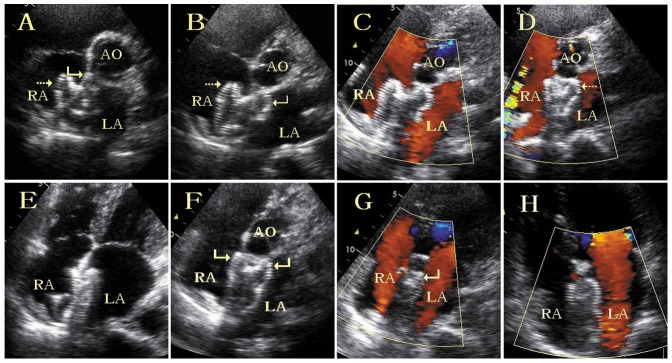
TTE images of the ASO in a patient with ASD with a deficient superior-anterior rim.(A) The left disc upper part was seen to be slipped into the right atrium (curved arrow). (B) After adjusted deployment, the upper parts of the two discs were positioned on the left and right side of the ascending aorta separately and opened as a “Y” shape (dashed and curved arrows). (C) No residual shunt was detected. The cable was pushed to make the right disc upper part press the ascending aorta tightly as shown in the parasternal short-axis view (D) and apical four-chamber view (E). After the ASO was released, the two ASO disc upper parts were positioned on the left and right side of the ascending aorta separately (curved arrows) (F) and no residual shunt was detected as shown in the parasternal short-axis view, the apical five-chamber view (G) and the apical four-chamber view (H). AO = ascending aorta, LA = left atrium, RA = right atrium.